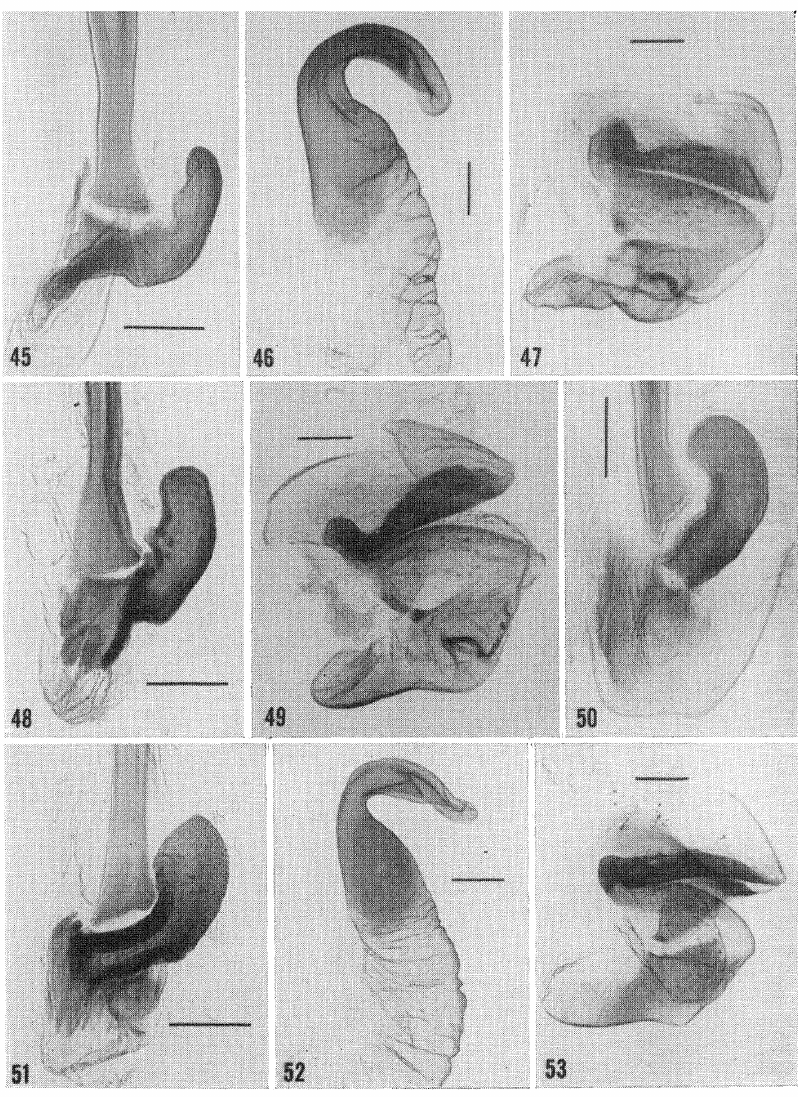
Figs. 45-53. 45-49. Lanxoblatta fra.ter. 45-47. (3 ANSP). Paratype. .A_ntioquia, Colombia. 48-49. (4 .ANSP). (from adult shown in Fig. 7). 50. (1 ANSP). Lanxoblatta lata. Muzo, Boyaci, Colombia. 51-53. (N). Lanxoblatta emarginata. From laboratory colony originating in Fl.ores, Manaus, .Amazonas, Brazil. (scale 0.2